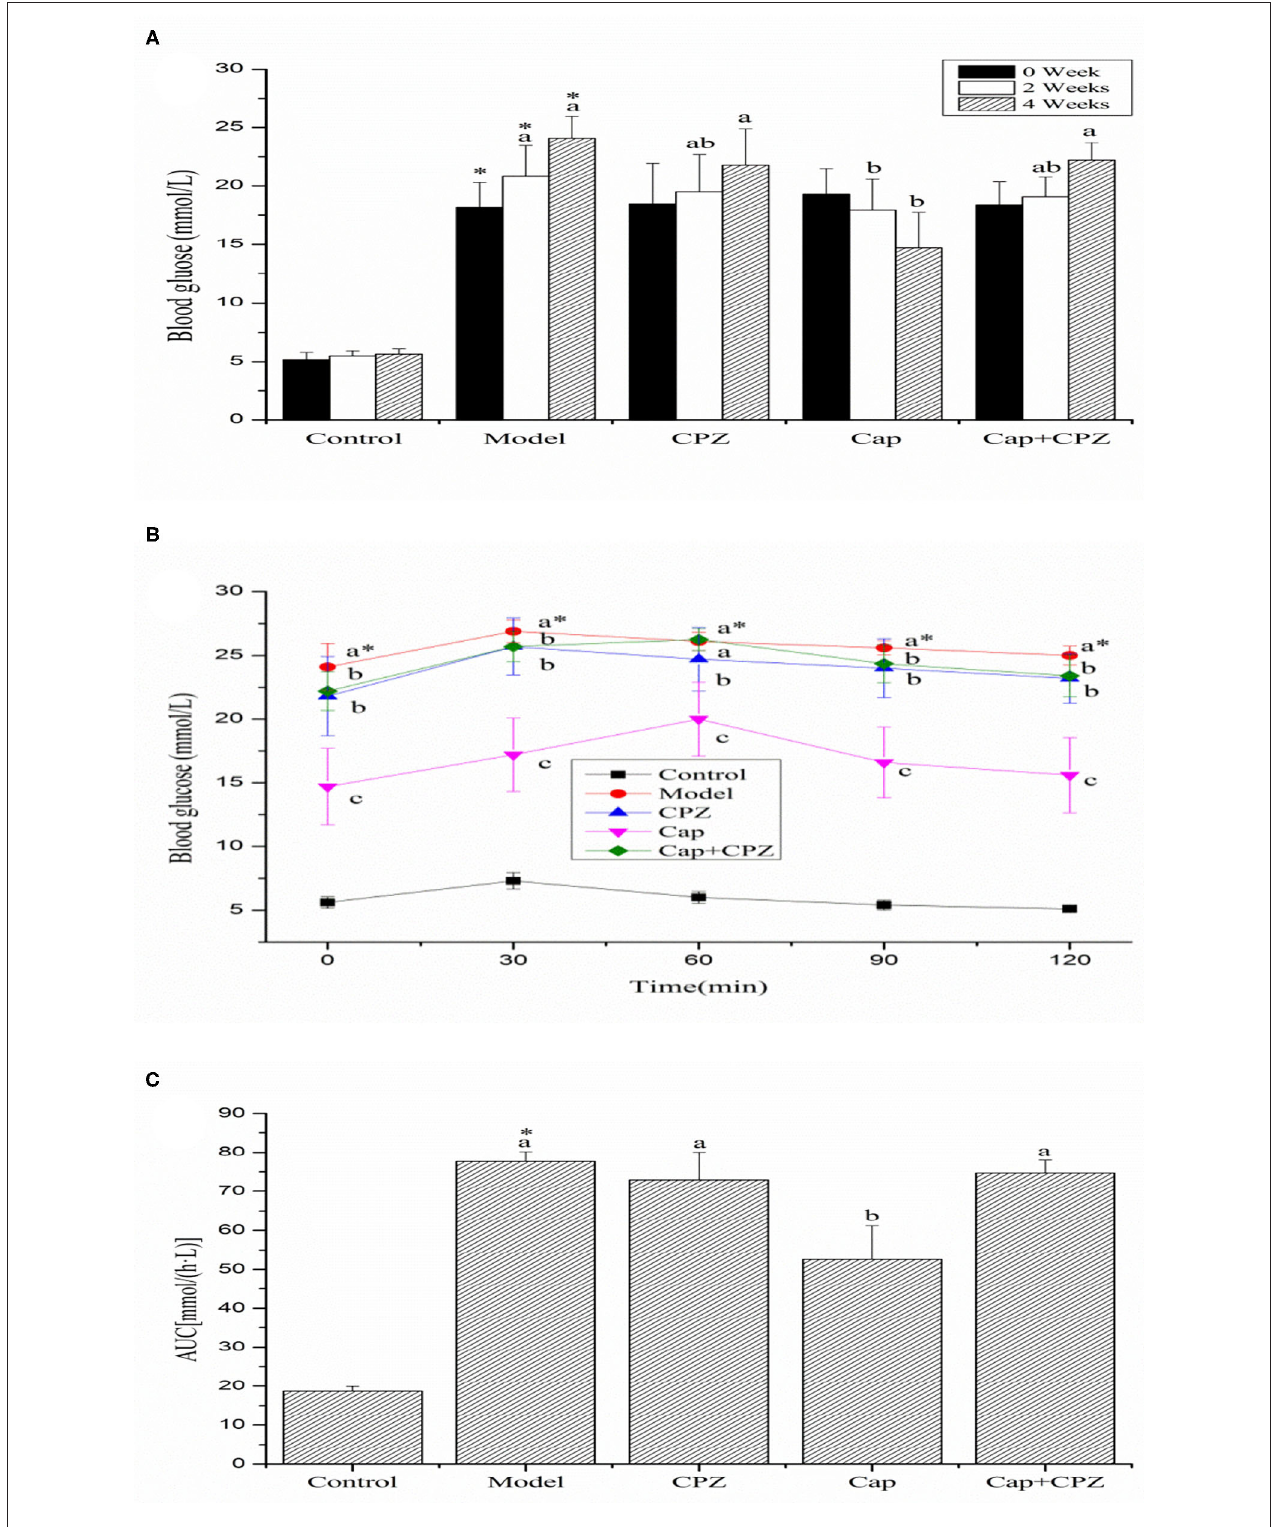
FIGURE 1 | Effects of TRPV1 receptor antagonist and capsaicin on the oral glucose tolerance test (OGTT) (A) , area under curve (AUC) (B) , and fasting blood glucose (C) in STZ-induced diabetic rats. All data are expressed as means ± SD, n = 8. *Means are significant difference compared with the control group ( P < 0.05). Means with different superscript letters are significantly different among the diabetes groups ( P < 0.05). Effective concentrations of capsaicin and capsazepine are 6 and 10 mg/kg · BW, respectively.